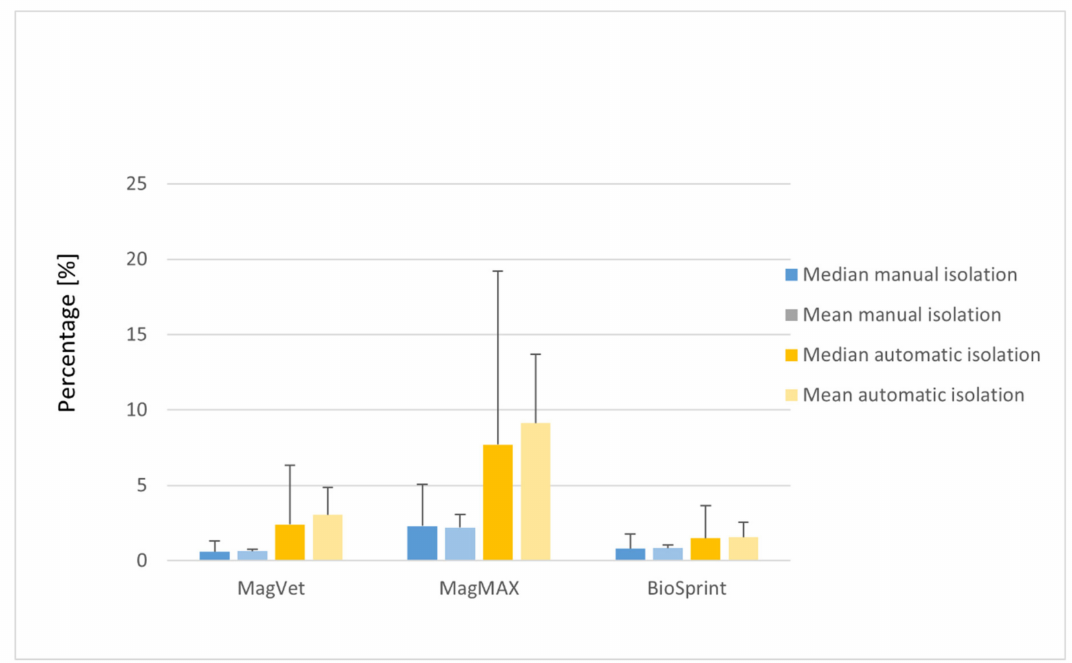
Figure 3. Comparison of MAP DNA isolation e ffi ciency of manual and automatic magnetic separation in milk using selected isolation kits; for detailed isolation kit information, see Figure 1. Error bars represent the 90th percentile and standard deviation for median and mean,